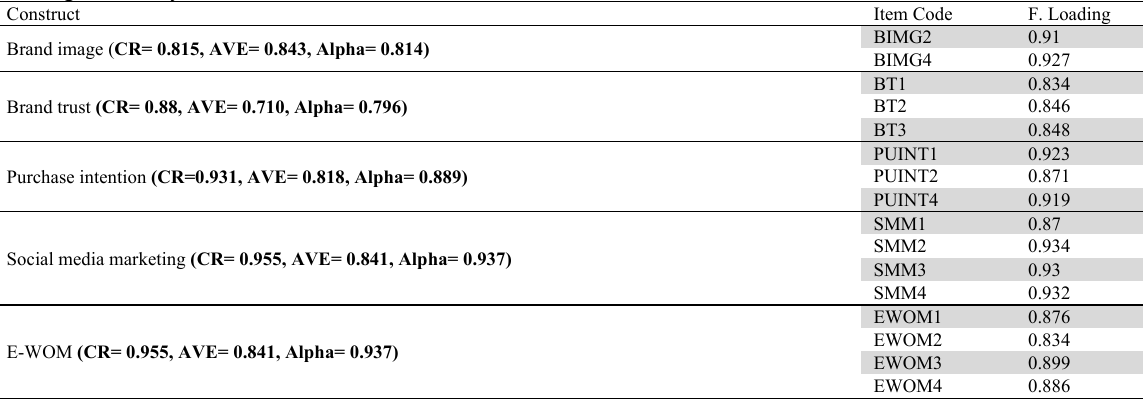
Convergent validity evaluation Construct